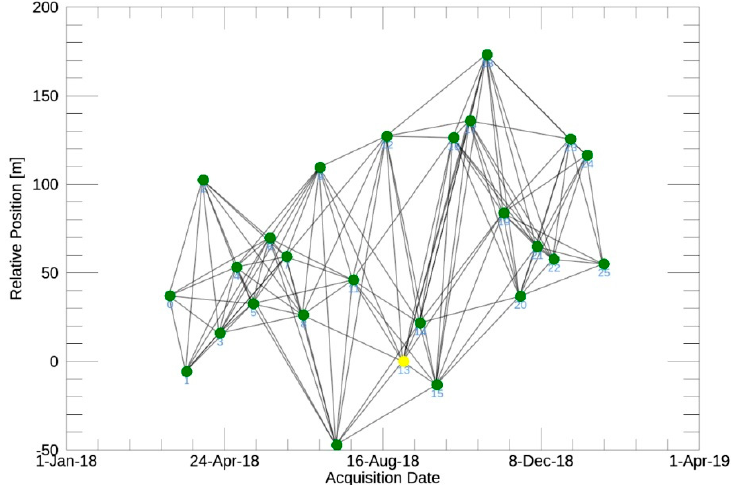
Figure 3. Interferometric pairs (solid lines) chose for SBAS (Small BAseline Subset) analysis; green dots correspond to the S1-B scenes and yellow dot corresponds to the reference scene for the co-registration (31 August 2018).